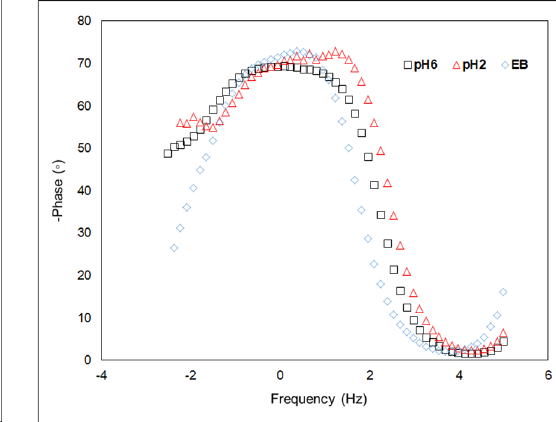
Figure 5. Nyquist Diagram of CoCrMo alloy in different solutions. Figure 6. Bode Diagram of Co-Cr-Mo alloy in different